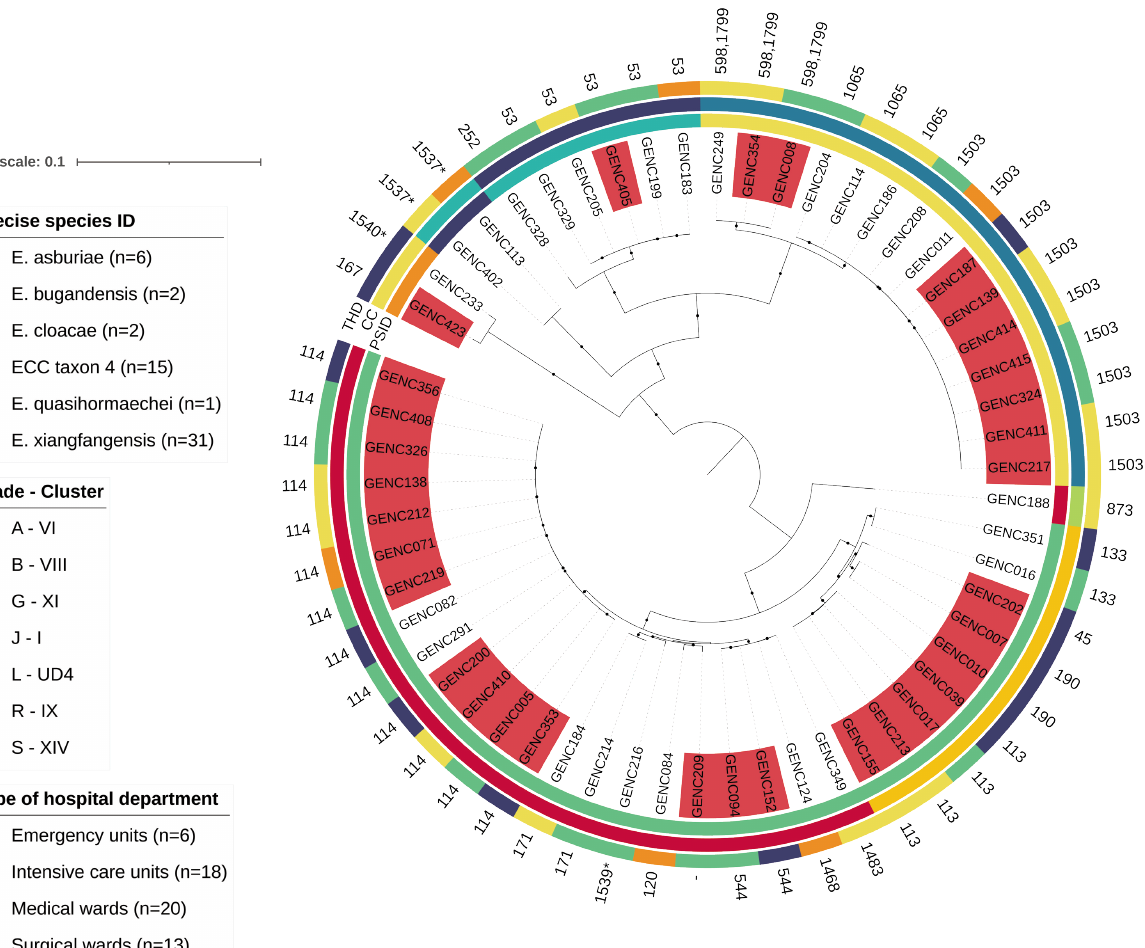
Figure 2. Maximum likelihood phylogenetic tree of clinical ESBL-producing E. cloacae complex (ECC) isolated between 2018 and 2019 in Guadeloupe. The core-genome phylogenetic tree was drawn from 57 genomes with iTOL. The tree was rooted at the mid-point and only bootstrap values equal to 100% are indicated by a black circle. The following metadata are indicated: the current species name (PSID) on the inner colored ring and the related ECC Sutton’s clade and hsp60 cluster (CC) on the second one [3,4,6]. The type of hospital department (THD) is indicated on the last circle. Strains with a bla CTX-M-15 gene with a location predicted on a plasmid and an IncHI2/ST1 plasmid replicon are in red. * New sequence types